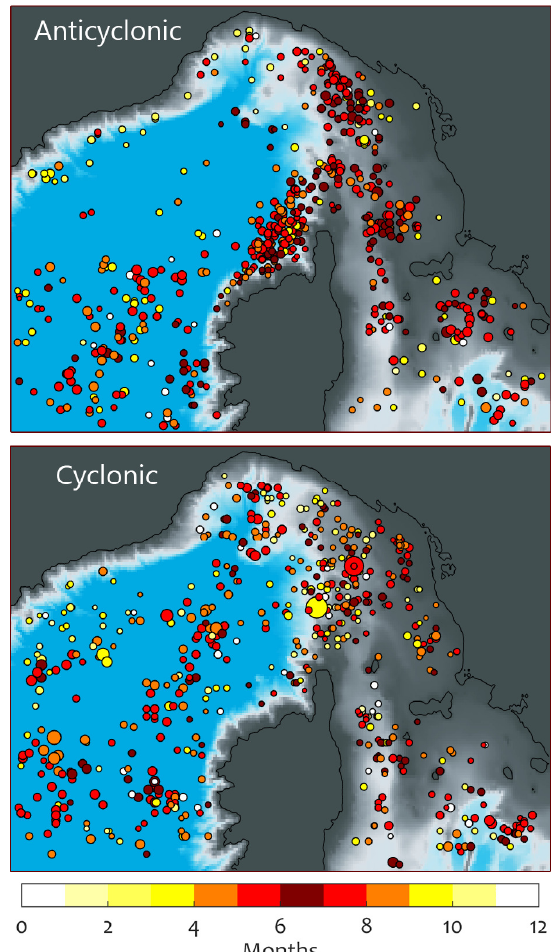
Figure 12. Spatial distribution of mesoscale eddy manifestations found in the fields of SST in 2014-2016 in the Liguro- Provençal Basin